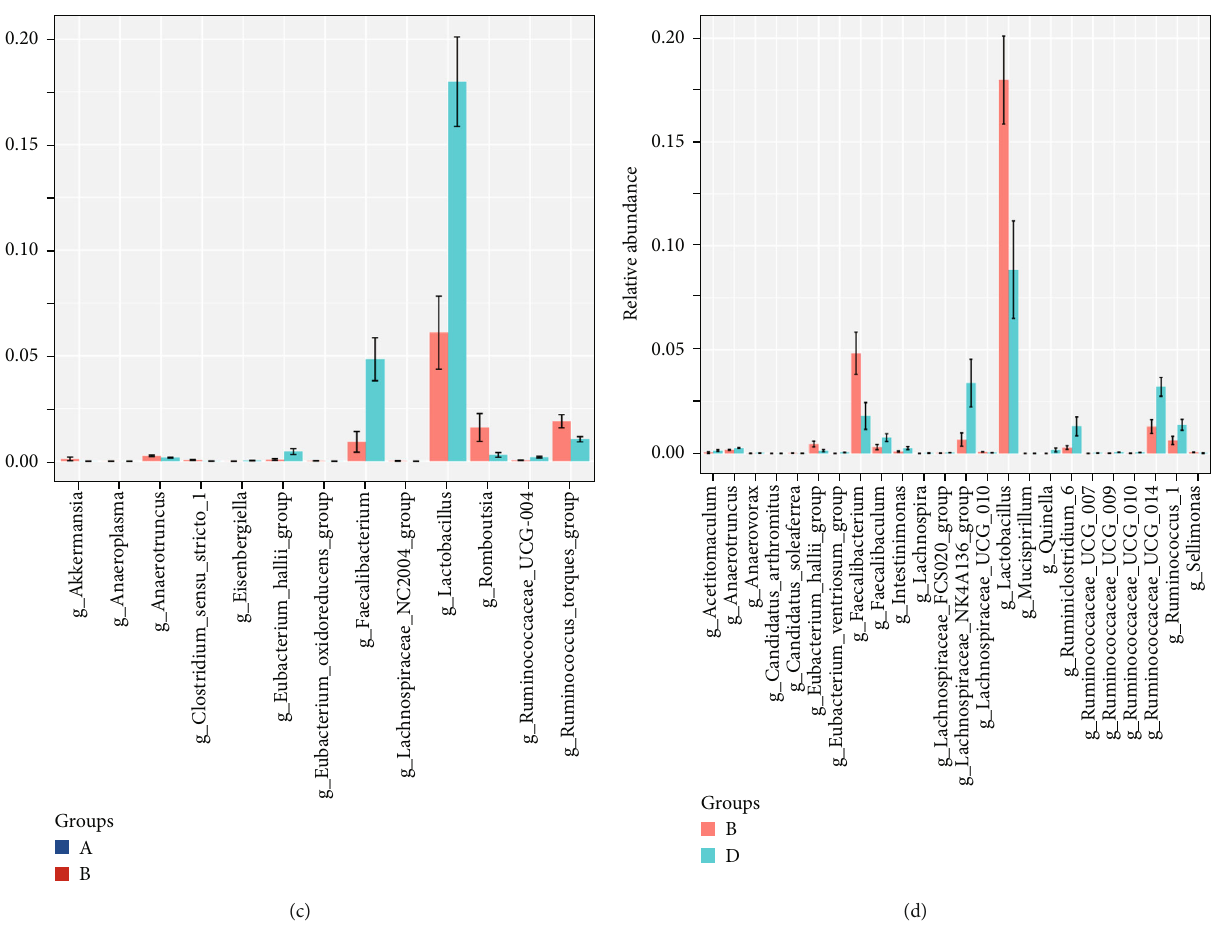
Figure 3: Composition analysis of the fecal microbiota. (a) The community structure of di ff erent groups at the phylum level (the x -coordinate is the group, and the y -coordinate is the relative abundance of bacteria in the group. The fi gure shows bacteria with relative abundance of more than 1%). (b) Heatmap analysis of species richness at the genus level (on the left is the cluster analysis of the relationship of the bacteria and the shades of color represent the abundance of the species). (c, d) Wilcoxon ’ s test between the two paired